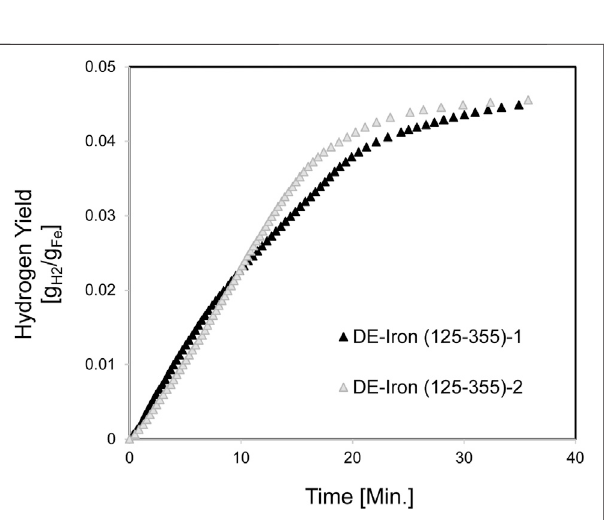
FIGURE 14 | The Hydrogen yield for mixed DE/Fe (125 – 355 µm) at set furnace temperature of 850 ° C.